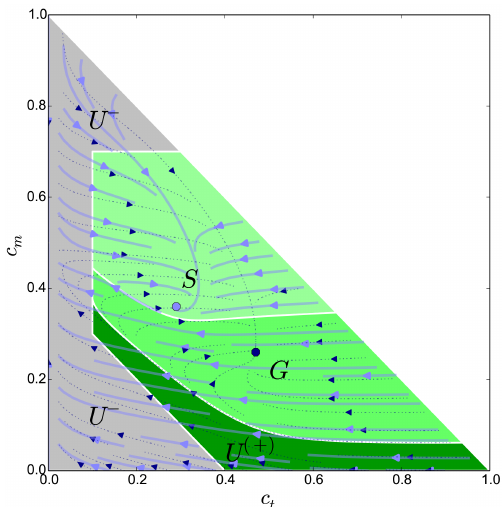
Figure 4. Phase portrait of the pre-industrial carbon cycle model of Anderies et al. (2013). Arrows indicate default/unmanaged dy- namics (pale blue) and alternative/managed dynamics (dotted dark blue) from reducing the human offtake rate by half. Filled dots: cor- responding stable fixed points. Grey area: undesired region defined by (i) upper bounds for maritime carbon c m (white horizontal line, representing a planetary boundary related to ocean acidification) and atmospheric carbon 1 − c t − c m (white diagonal line, related to a climate change boundary) and a lower bound for terrestrial carbon c t (white vertical line, representing an ecosystem services planetary boundary). Coloured areas and labels: derived state space partition (see text); colours as defined in Fig. 2: a shelter S around the glob- ally stable fixed point of the default dynamics, a glade G from where S can be reached by management without violating the bounds, and a remaining sunny upstream U ( + ) from where one cannot avoid vi- olating the bounds